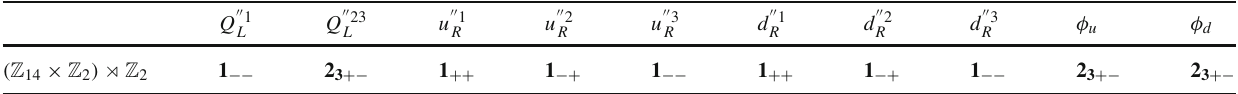
Table 2 Representations of the quarks under ( Z 14 × Z 2 ) (cid:2) Z